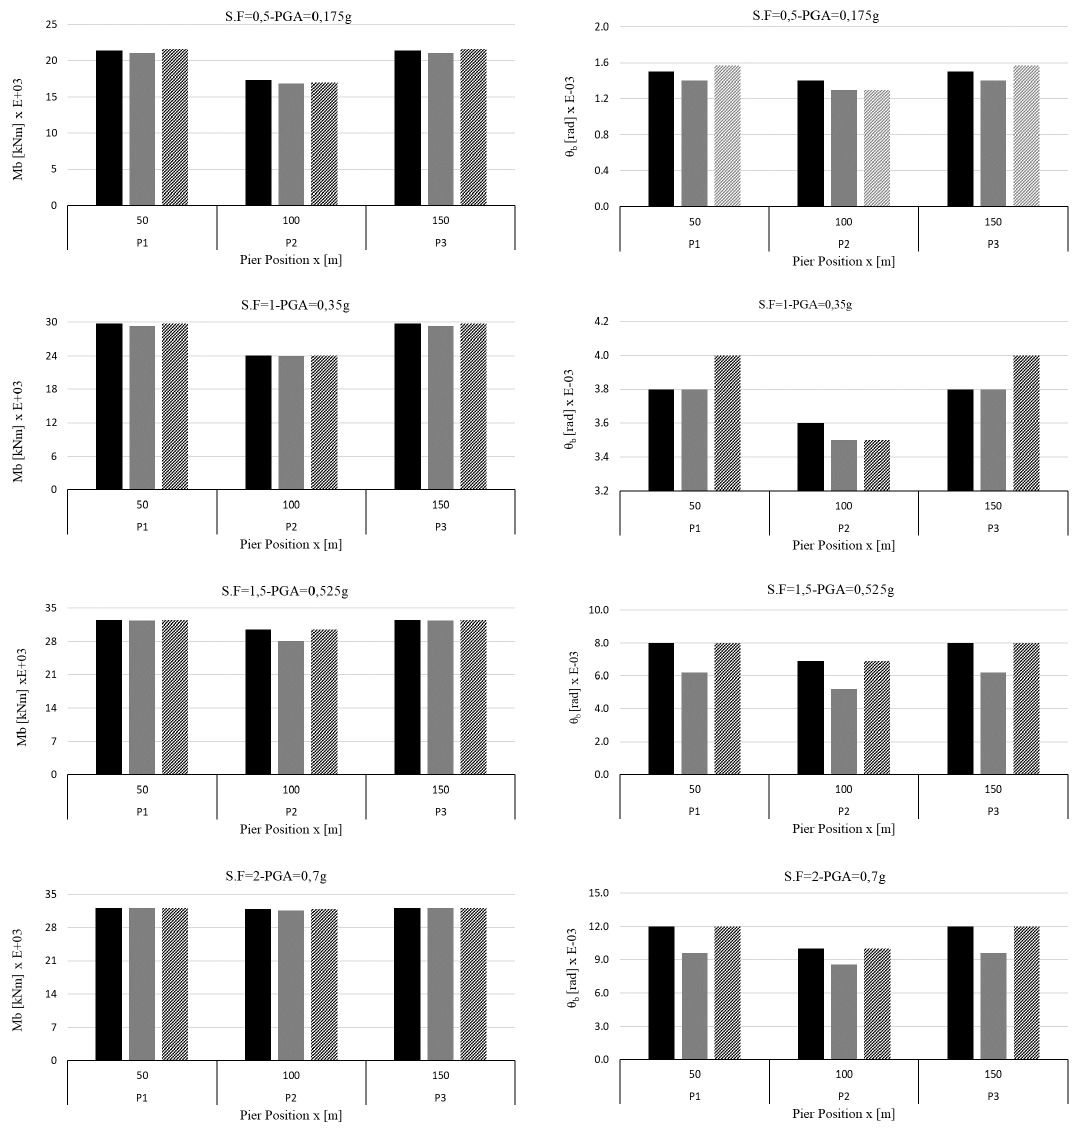
Figure A2. Regular bridge—bending moment (M b ) and curvatures (q b ) at the hinge location, derived by performing nonlinear dynamic analysis and pushover analysis (PGA from 0.175 to 0.7